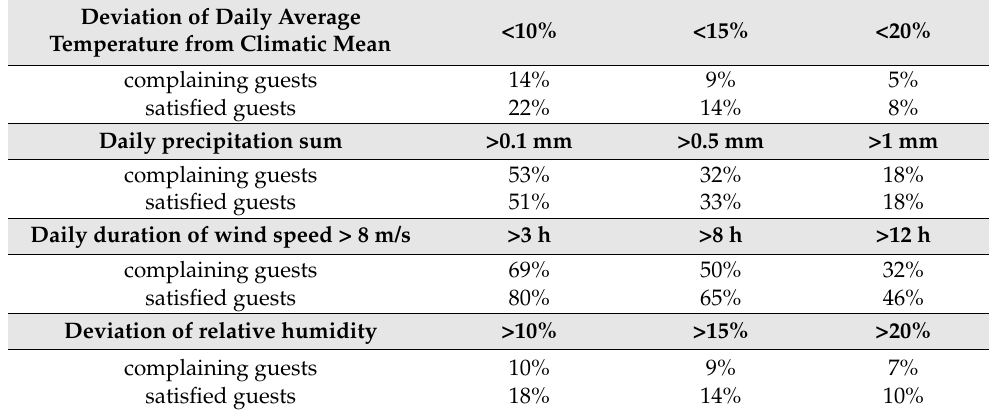
Table 3. Portion of guests (complaining and satisfied) depending on the meteorological conditions during their